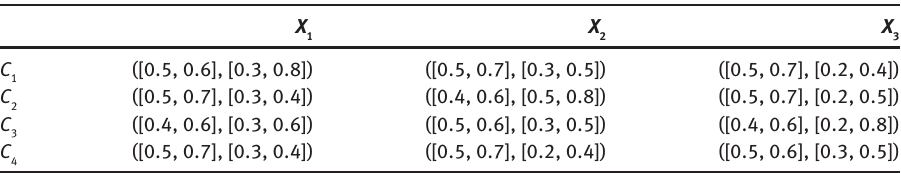
Table 6: Normalized Pythagorean Fuzzy Decision Matrix R 3